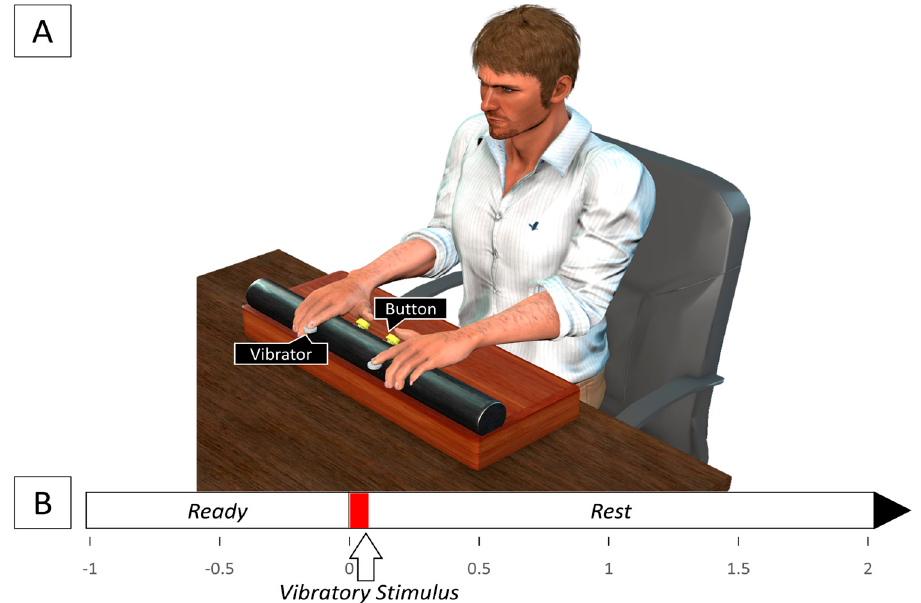
Figure 1. ( A ) Experimental set-up; ( B ) Timeline of events for a single trial. The vibratory stimulus (indicated by the red area) is presented for 100 ms at the beginning of each trial randomly to either the right or left index finger